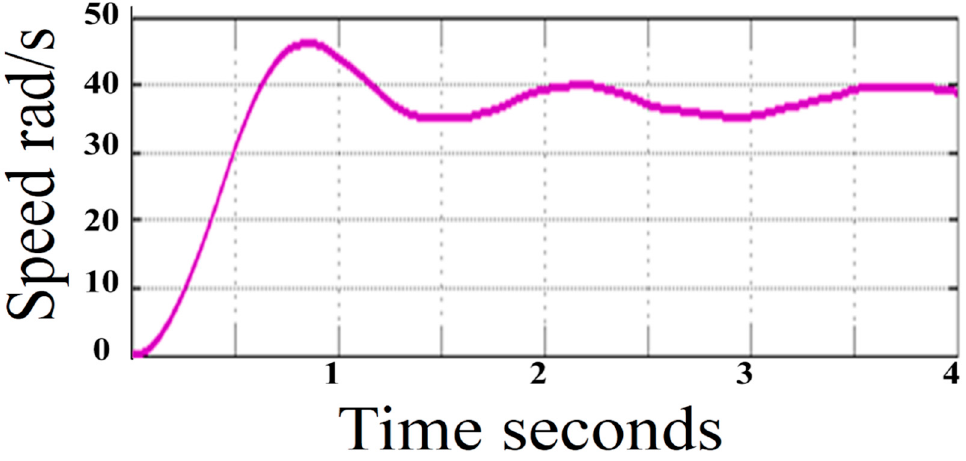
Figure 13. Simulation of the best result for ST2FDE with noise 0.5 FLC. Figure 14 represents the simulation of the best result, 5.59 × 10 − 01 This value can be seen in Table 5, and the simulation represents the simulation with noise of 0.7 in the controller using ST2FDE.